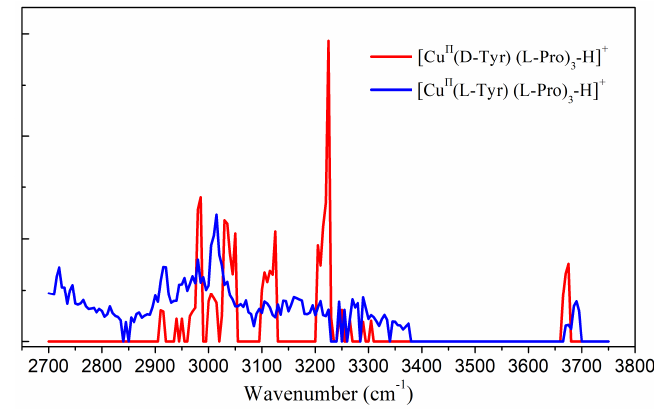
Figure 12. Experimental IRMPD spectra of [(Cu II ) ( D / L -Tyr)( L -Pro) 3 − H] + .